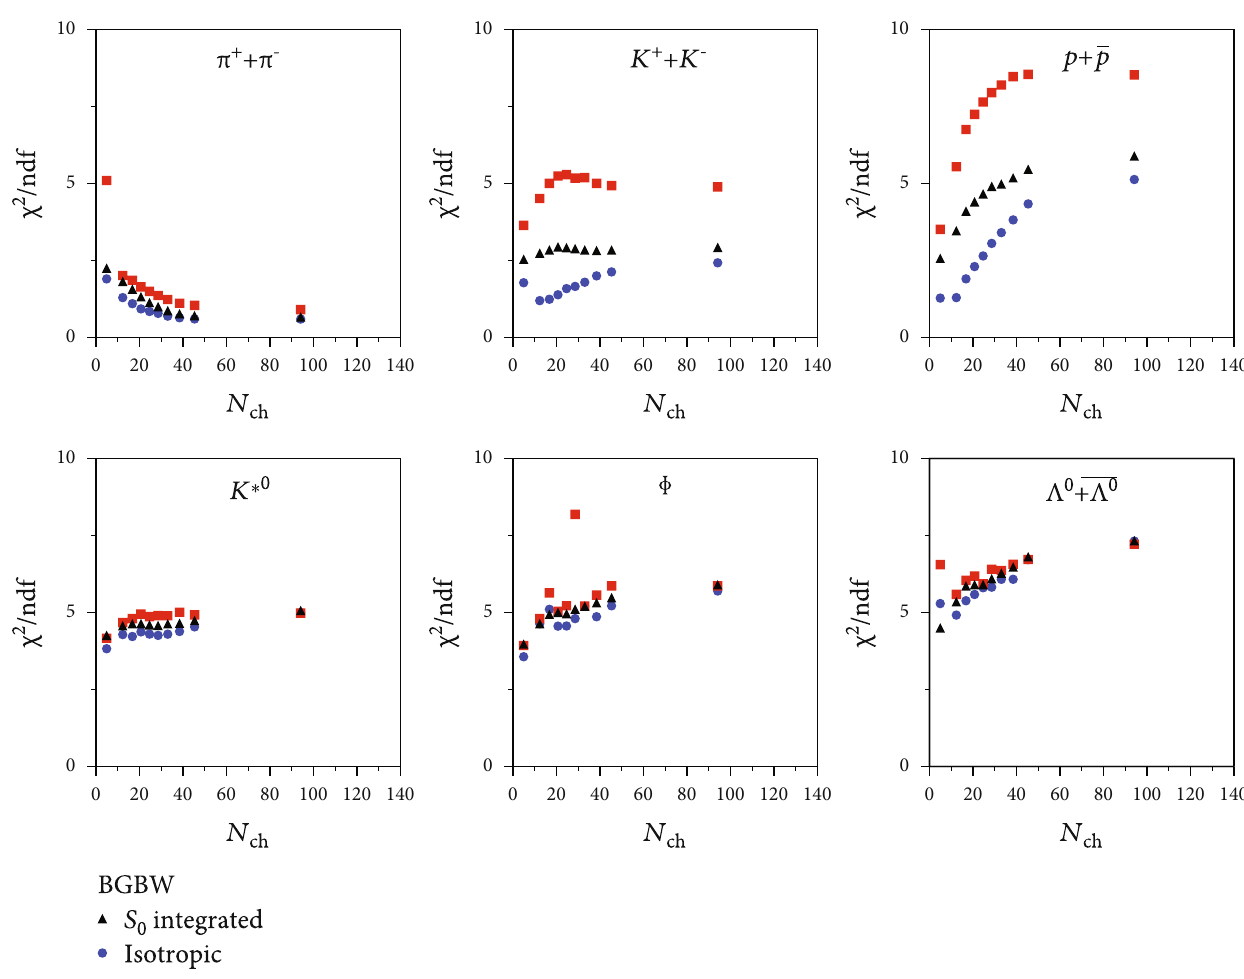
Figure 14: (Color online) χ 2 /NDF for the fi tting of generated p and multiplicity